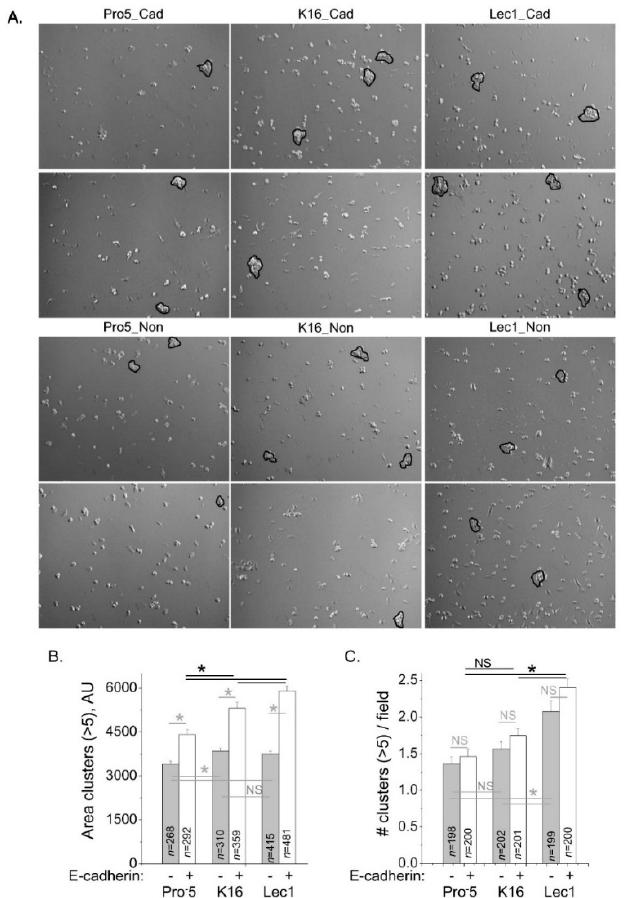
Figure 7. E-cadherin modified cell–cell adhesion in cells expressing different types of N -glycans. Microscopy images were acquired for E-cadherin transfected Pro − 5 and non-transfected Pro − 5, K16, and Lec1 ( A ); particles (>5 cells per cell cluster) analyzed are encircled. Mean values of the area ( B ), and number ( C ) of cell clusters were plotted on bar graphs from four separate days of experiments, as indicated. n values were greater than 199 fields and 267 clusters. Black asterisks denote significant differences in mean values of a non-transfected cell line, and E-cadherin transfected cell line at a probability of p < 0.00001 using student t -test ( B ). Gray asterisks represent significant differences in mean values of non-transfected or E-cadherin transfected CHO cell lines at a probability of p < 0.05 using one-way ANOVA with Bonferroni adjustments. NS signifies mean values were not significantly different.